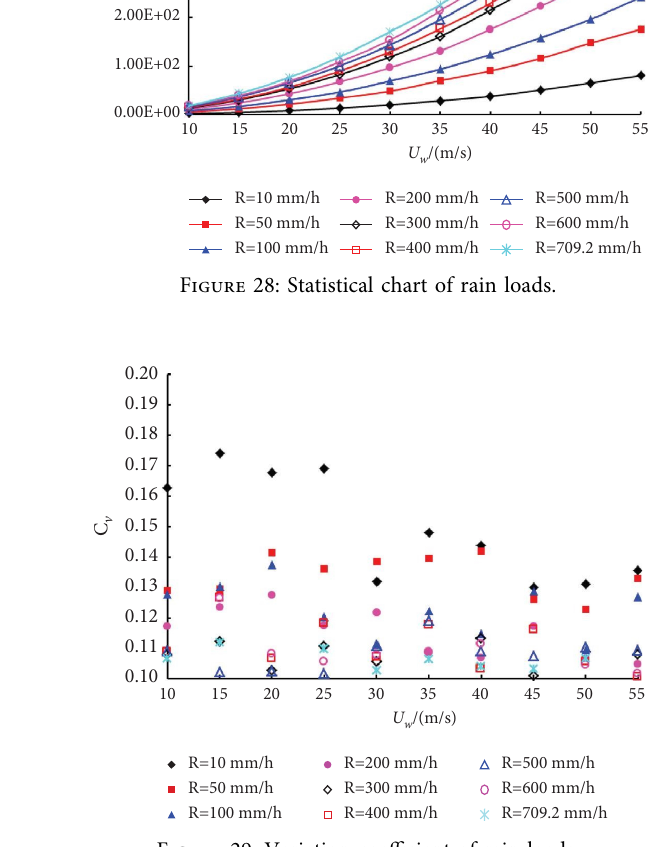
Figure 29: Variation coefcient of rain loads.